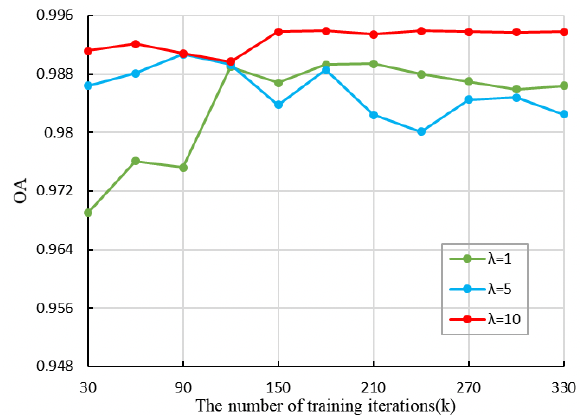
Figure 6. Sensitivity analysis for the hyper-parameter λ in the loss function of Auto-GAN on the test data.